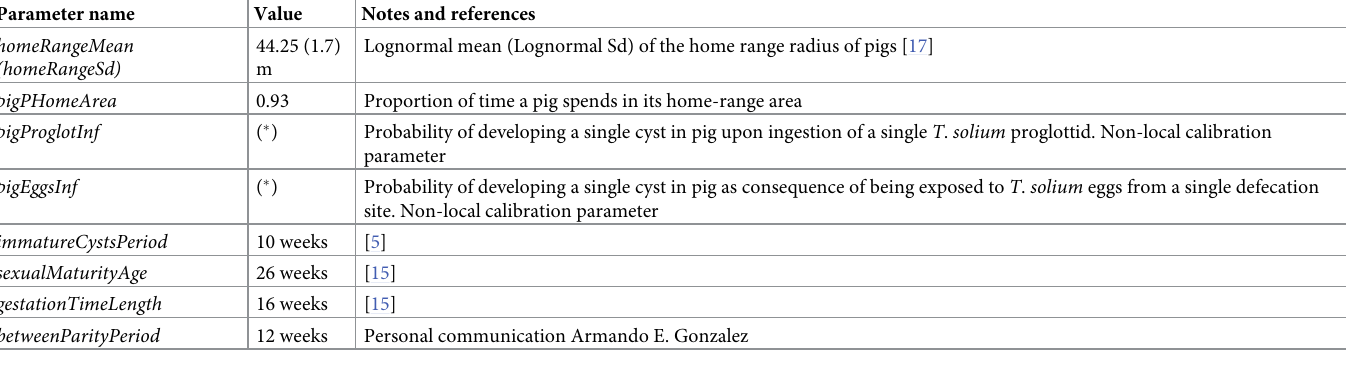
Table 4. Pig module